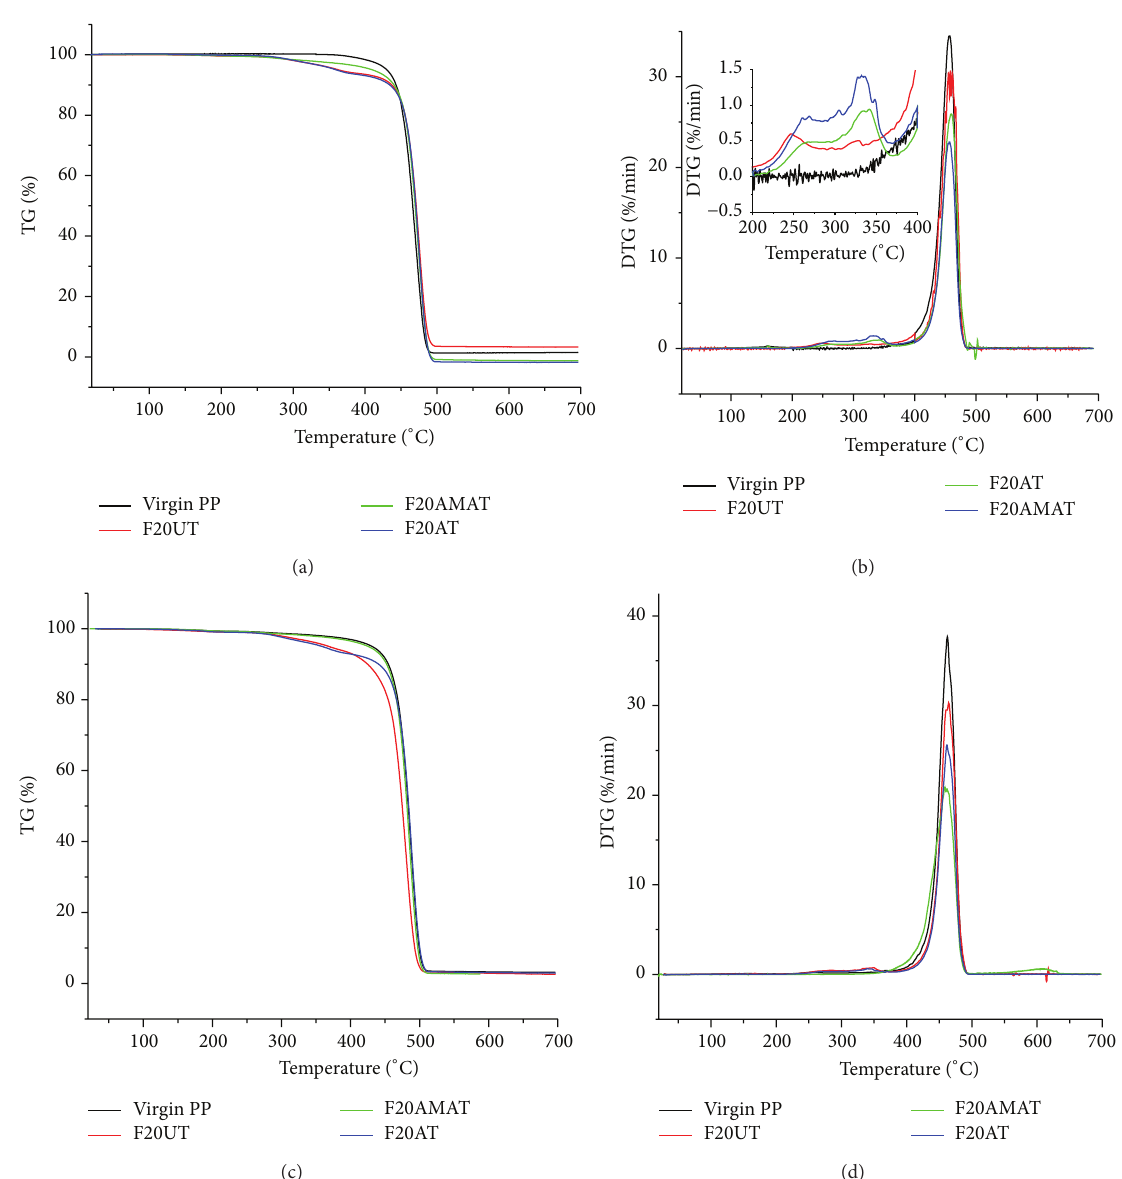
of a compatibilizing agent and the chemical modification by acetylation of fibers have no effect on the composite during the hydrothermal